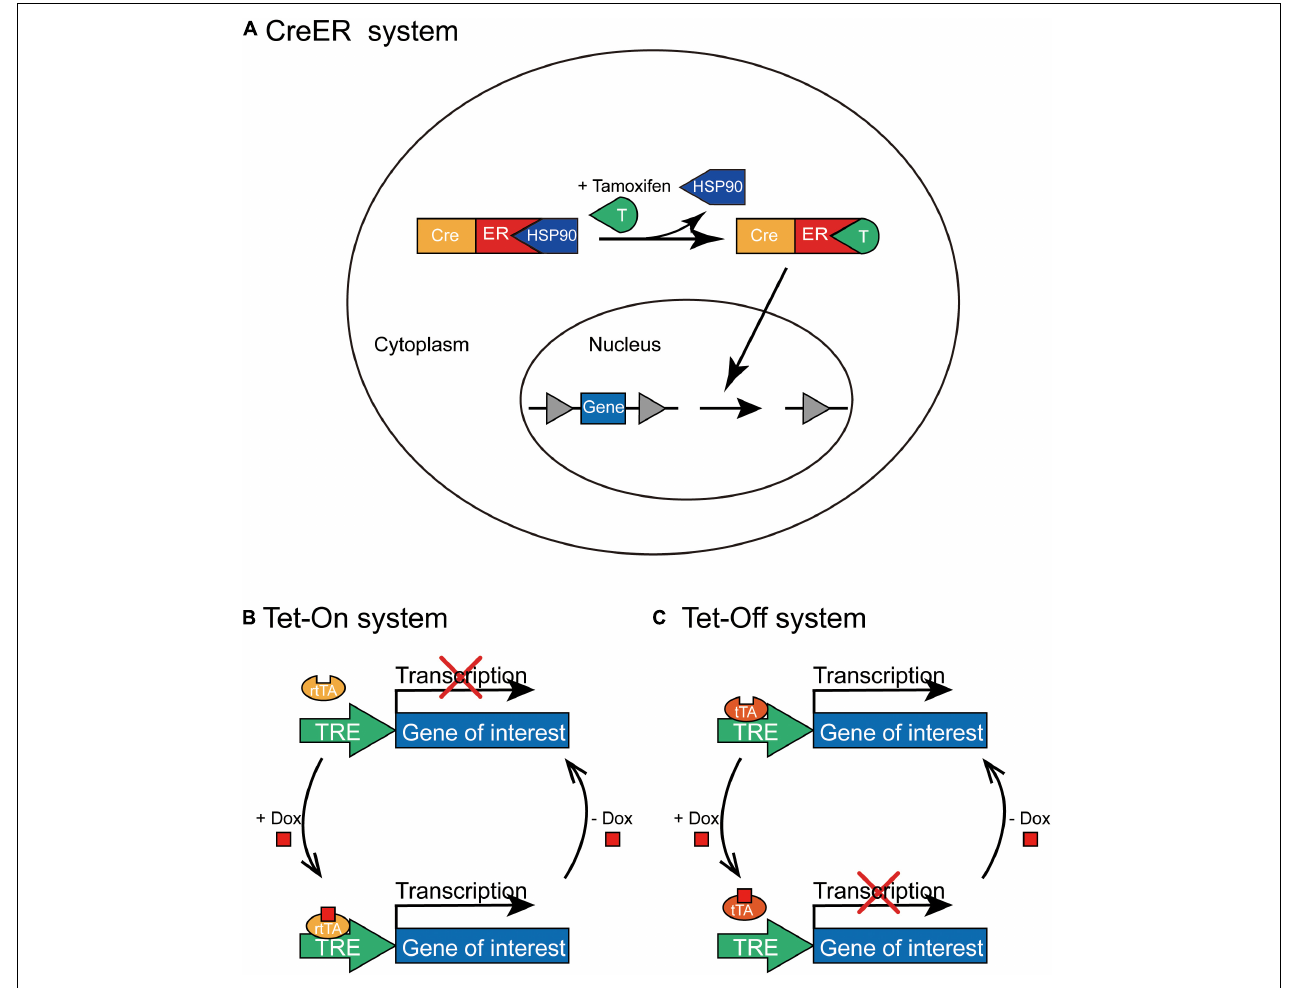
FIGURE 4 | The schematic depiction of CreER and Tet-On/Tet-Off inducible systems. (A) In the CreER system, CreERT2 combines with HSP90 without tamoxifen administration and is situated in the cytoplasm. Tamoxifen can replace HSP90 to specifically bind with CreERT2 and lead to the nuclear translocation of CreERT2-tamoxifen complex; thus, Cre-mediated recombination initiates the expression of transgene in the presence of tamoxifen. (B) In the Tet-On system, rtTA combines with TRE only in the presence of Dox to activate the transcription of the transgene; however, rtTA cannot combine to the TRE without the administration of Dox. (C) In the Tet-Off system, tTA binds to TRE in the absence of Dox to initiate the transcription of the transgene; however, tTA cannot bind to TRE with the administration of